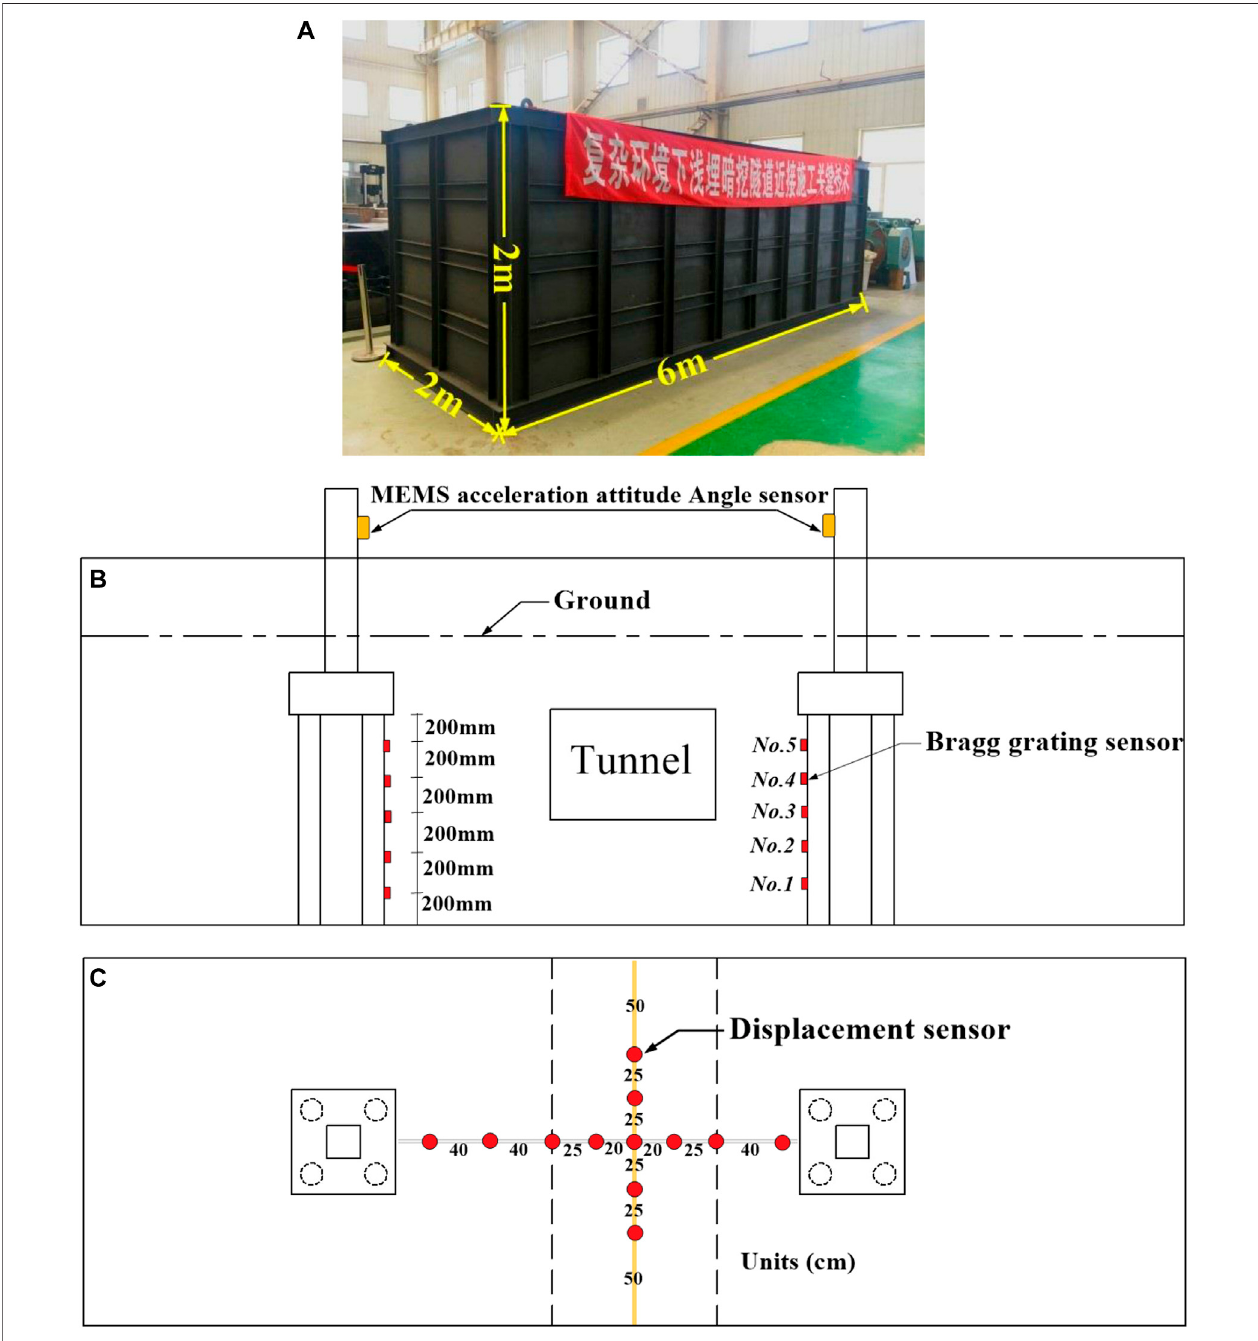
FIGURE 8 | Test model tunnel and deployment of monitoring equipment and test data collection points: (A) Test model tunnel; (B) Front elevation; (C) Top view.